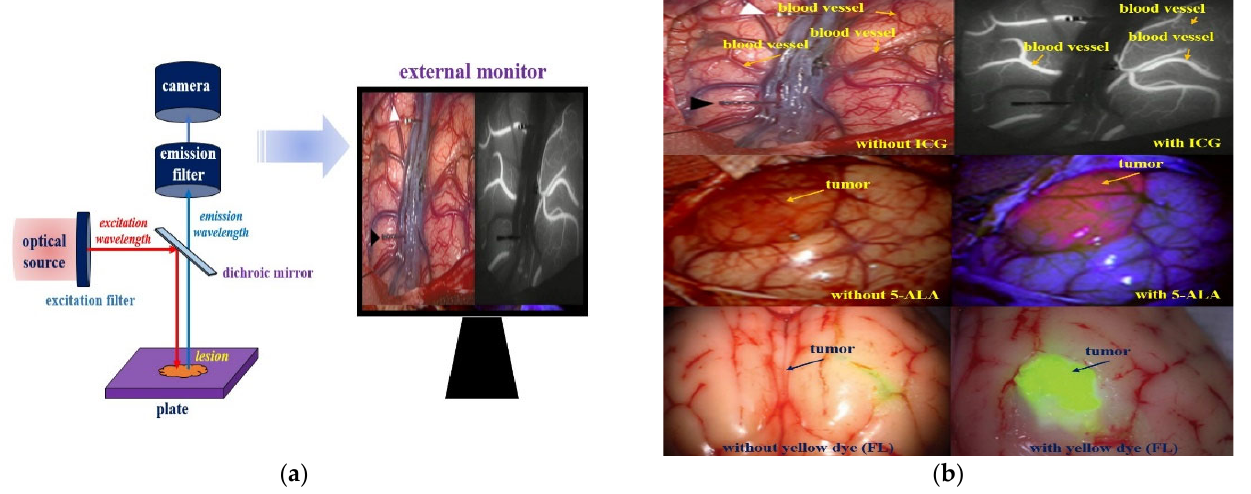
Figure 1. ( a ) Schematic of the fluorescence surgical microscope and external tissue monitoring. ( b ) Observation imaging of tumor during surgery using a surgical microscope.